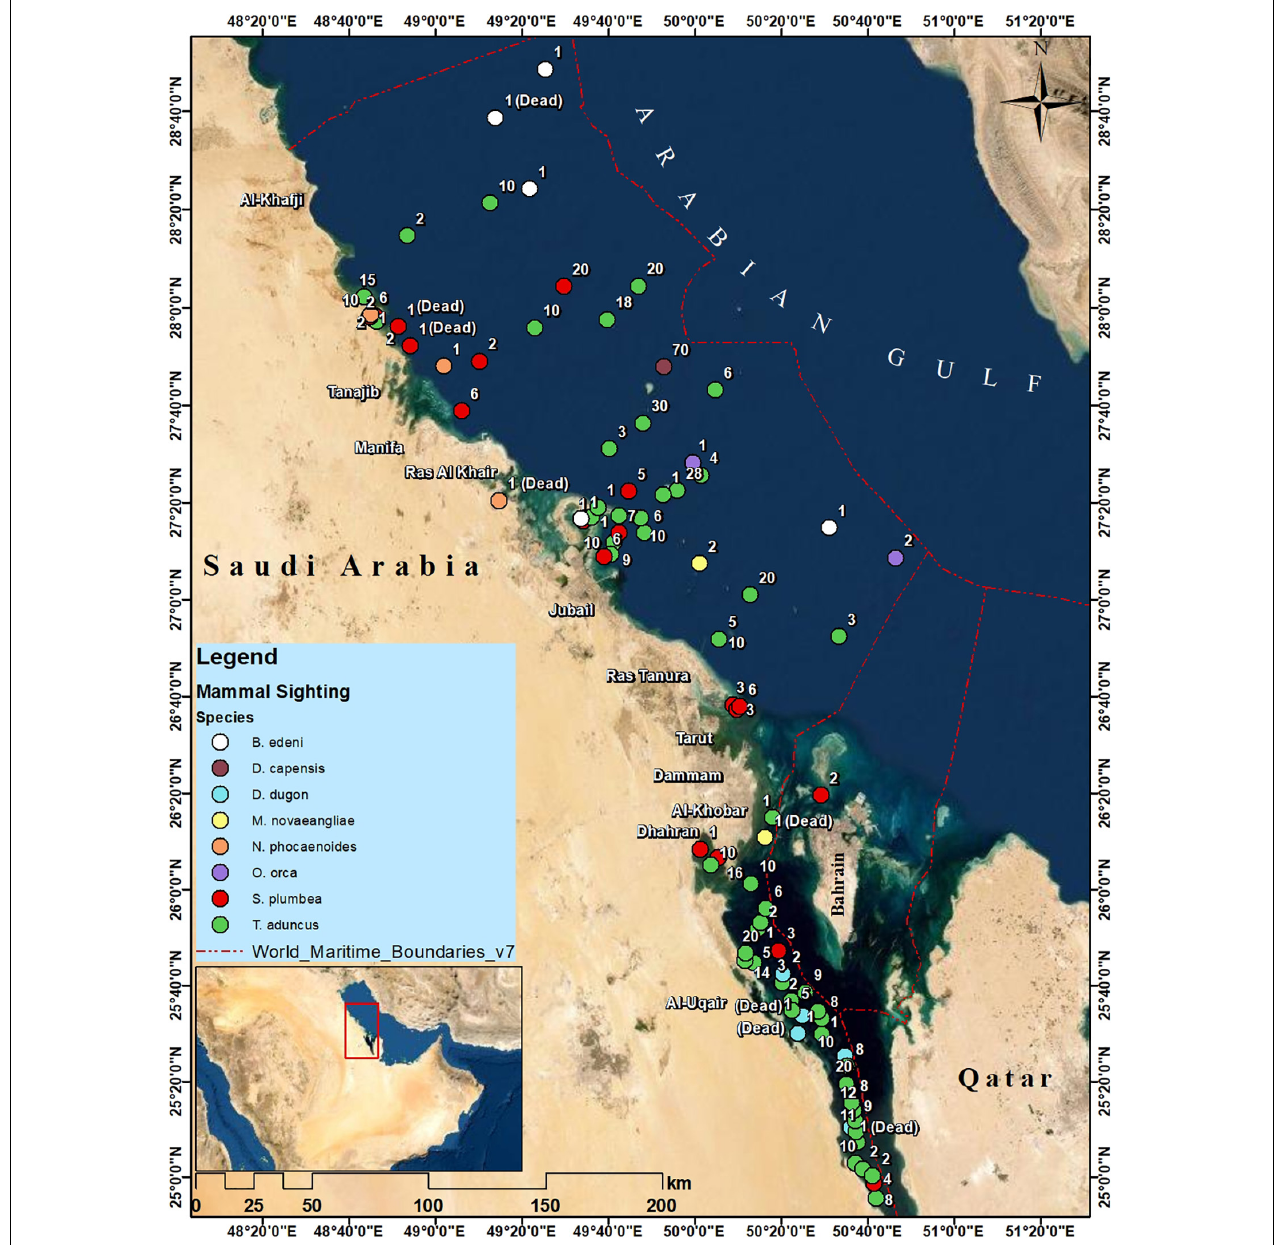
FIGURE 3 | Map showing the locations of opportunistic sighting reports of marine mammals (whales, killer whales, dugongs, and dolphins) in the Saudi waters of the Arabian Gulf (between February 2016 and August 2020). Numbers represent the number of individuals at each sighting.